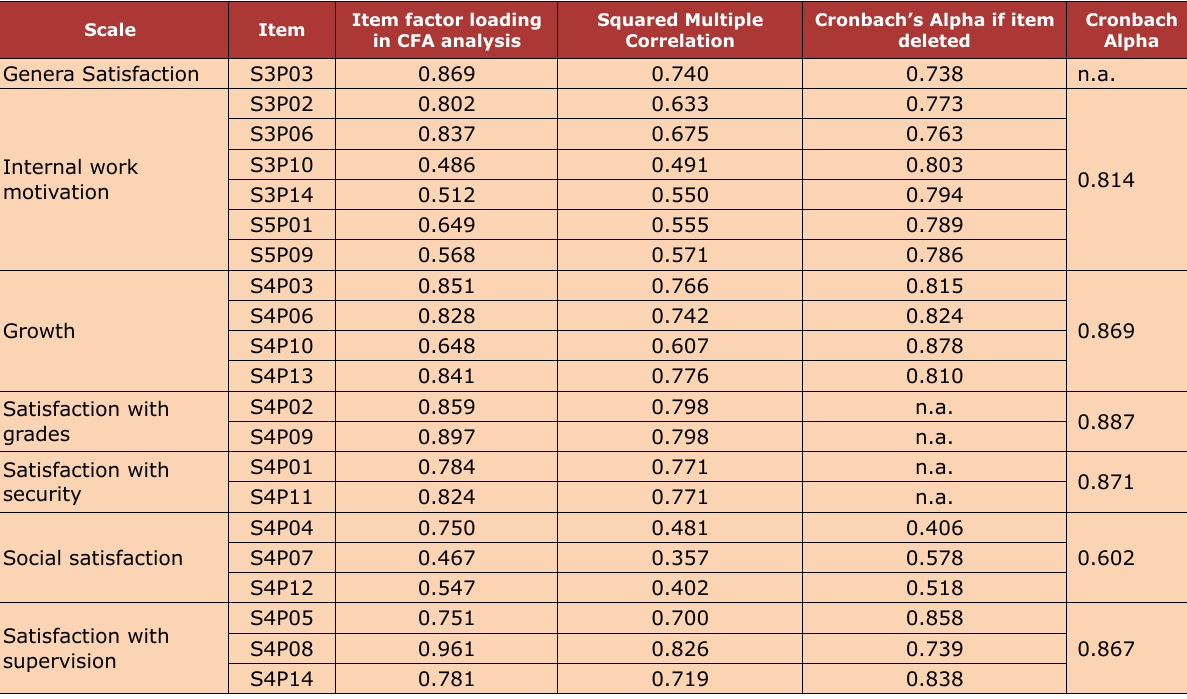
Table 4. Internal consistency of satisfaction scales (n.a.= not